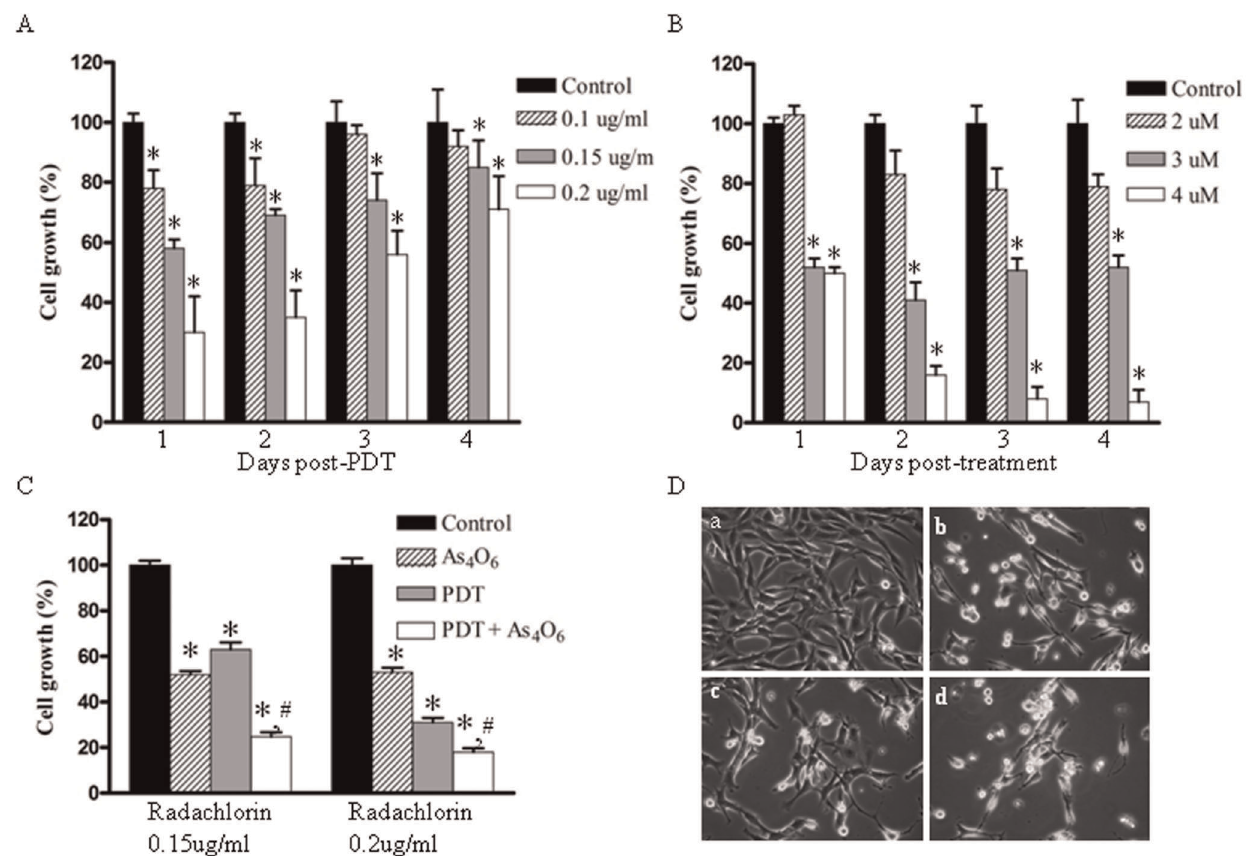
Figure 1. Cell growth inhibition effects of photodynamic therapy and As 4 O 6 . (A) TC-1 cells (3 6 10 3 ) were cultured in 12-well plates in triplicate overnight and treated with different concentrations of Radachlorin and PDT (6.25 J/cm 2 ) as described in Materials and Methods. After PDT, the cells were cultured for a predetermined time. (B) Inhibition effects of cell growth of As 4 O 6 on TC-1 cells. TC-1 cells were cultured and treated as described in Materials and Methods. After As 4 O 6 treatment, the cells were cultured for a predetermined time. Cell viability was determined based on the MTT assay. (C) In vitro cell growth inhibitory effects of As 4 O 6 plus Radachlorin/PDT on TC-1 cells. TC-1 cells were cultured with 3 uM of As 4 O 6 and different doses of Radachlorin/PDT for 1 day, as described above. Cell viability was determined based on the MTT assay. Each bar represents a mean [ 6 SD (vertical line)] of three replicates per dose ( n =3). * and # : significantly different ( P , 0.05) from the control and the PDT by the student’s t-test. (D) Morphological changes of TC-1 cells. TC-1 cells were treated with 0.15 ug/ml Radachlorin/PDT or/and 3 uM of As 4 O 6 for 1 day. Cells were then viewed under microscope. Pictures were taken with phase contrast microscopy at X300. (a) non-treated; (b) 0.15 ug/ml Radachlorin/PDT alone; (c) 3 uM As 4 O 6 alone; (d) 3 uM As 4 O 6 plus 0.15 ug/ml